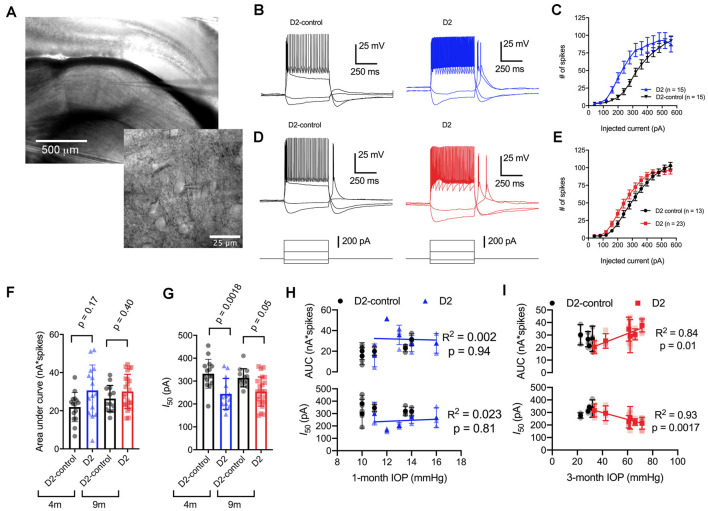
Enhancement of thalamocortical (TC) neuron spiking in D2 mice. (A) Left, microscopy image of dorsal lateral geniculate nucleus (dLGN) with a patch-clamp electrode in a coronal brain slice. Right, higher magnification image showing a TC neuron with the patch-clamp electrode. (B) Evoked spiking responses to depolarizing current injection (+120 and + 320 pA) and voltage deflections to hyperpolarizing current injections (−20 and −80 pA) in 4 m D2 mice (15 cells, five mice) and D2-control mice (n = 15 cells, five mice). (C) Plot of current injection and counts of evoked spikes (mean ± SEM) show that TC neurons from 4 m D2 mice fired more spikes (unpaired t-test). (D) Spiking and hyperpolarizing voltage responses from 9 m D2-control and D2 mice. (E) Similar to panel (C), TC neurons from 9 m D2 mice (n = 23 cells, six mice) were slightly more excitable than from D2-control mice (n = 13 cells, four mice). (F) Mean ± SD of the area under the curve of spiking responses and data points from individual cells from 4 to 9 m D2 and D2-control mice. Significance was assessed using a nested t-test approach. (G) Mean ± SD and individual cell data points of the half-maximal current injection from a Boltzmann fit to the current-spiking relationships. (H) There was no significant correlation of area under the curve (AUC) or I50 with IOP (measured at 4 m of age) as assessed with linear regression for 4 m D2 mice. Regression was performed on mean values of AUC and I50 for each mouse rather than on individual cells. (I) In 9 m D2 mice, there was a significant correlation of AUC and I50 with a 3-month cumulative IOP averaged across two eyes for each mouse.